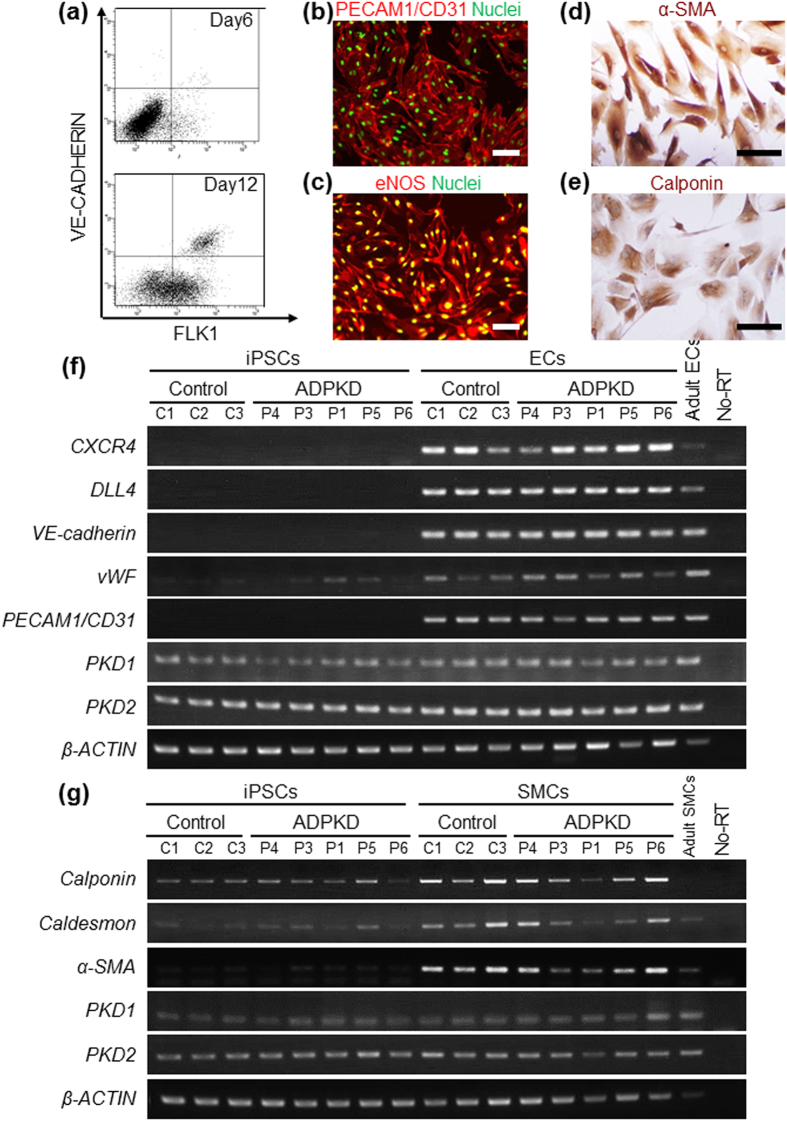
Directed Differentiation of ADPKD-iPSCs into Vascular Endothelia and Smooth Muscle Cells.(a) Flow cytometric analyses of ADPKD iPSC-derived cells on culture days 6 (upper) and 12 (lower). (b,c) Immunostaining of vascular endothelial cells (ECs) on day 12 differentiated from P4-iPSC-derived VE-CADHERIN (+) FLK1 (+) cells for the endothelial markers PECAM1/CD31 (b) and endothelial NO synthase (eNOS) (c). (d,e) Immunostaining of vascular smooth muscle cells (SMCs) on day 25 differentiated from P4-iPSC-derived VE-CADHERIN (−) FLK1 (+) cells for the smooth muscle cell markers α-smooth muscle actin (αSMA) (d) and Calponin (e). (f) The expression of marker genes (CXCR4, DLL4, VE-cadherin, vWF and PECAM1/CD31) and PKD1 and PKD2 in ECs derived from three control-iPSC (C1-3) and five ADPKD-iPSC lines (P4, P3, P1, P5 and P6). (g) The expression of marker genes (Calponin, Caldesmon and α-SMA) and PKD1 and PKD2 in SMCs derived from the control- and ADPKD-iPSC lines. Scale bars, 100 μm. See also Figures S7–S9.